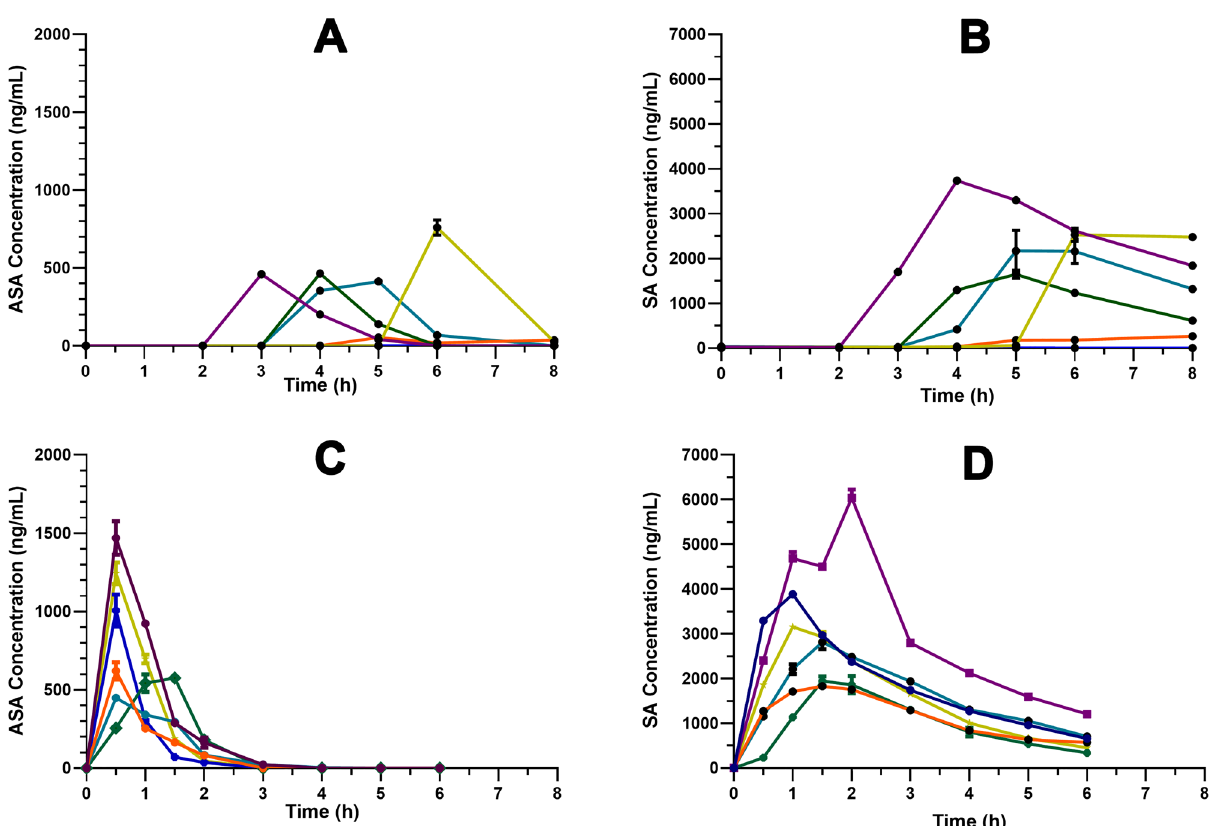
Figure 4. Plasma levels of ASA and SA in HS (n = 6) after EC-ASA and plain-ASA administration. In detail: ( A ) ASA levels after EC-ASA treatment; ( B ) SA levels after EC-ASA treatment; ( C ) ASA levels after plain-ASA treatment and ( D ) SA levels after plain-ASA treatment.